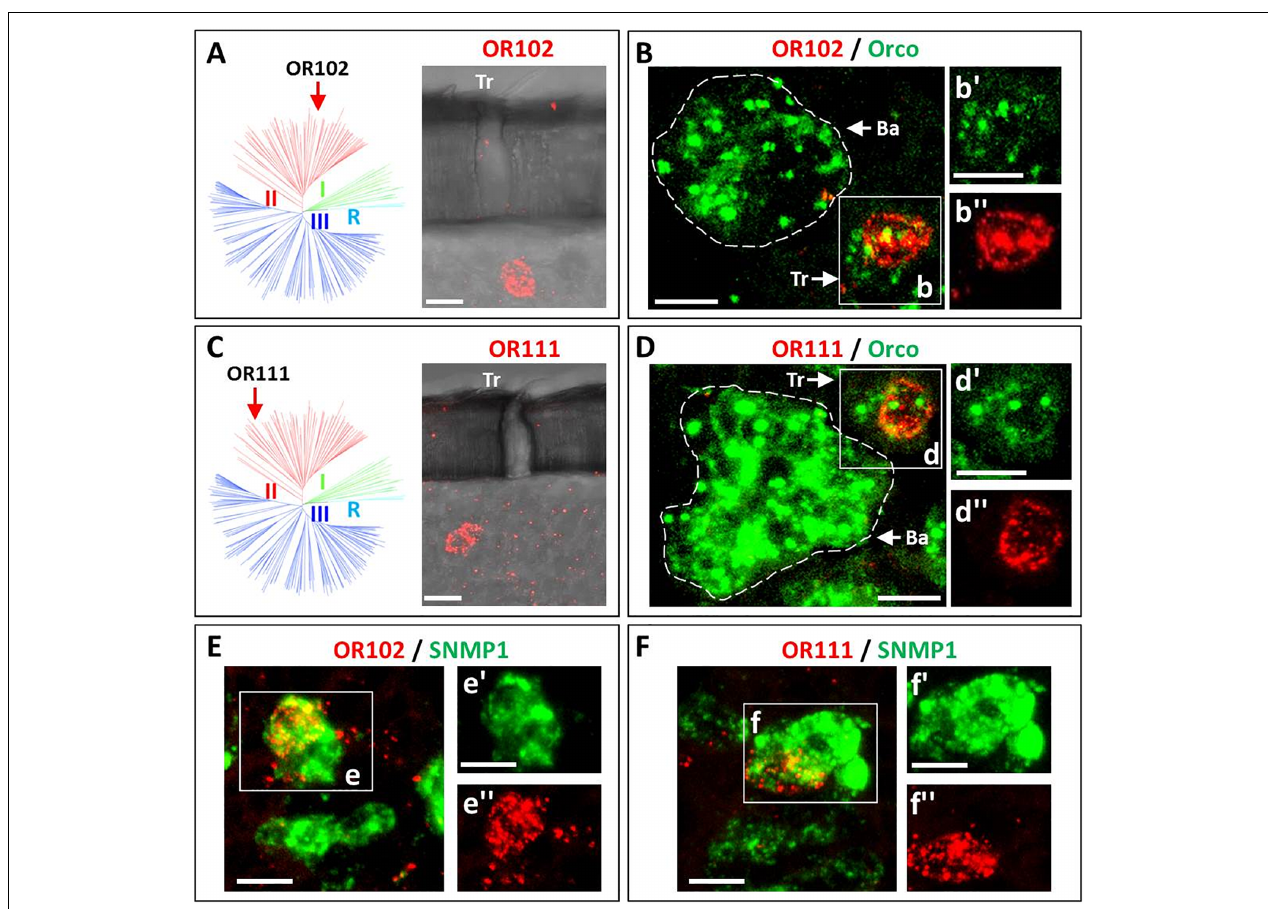
FIGURE 3 | Two ORs from group II are specifically expressed in sensilla trichodea. Cells expressing distinct OR types as well as Orco or SNMP1 were visualized by means of two-color FISH using specific antisense riboprobes labeled in either DIG (OR, red fluorescence) or Bio (Orco and SNMP1, green fluorescence). (A–D) The expression of OR102 and OR111 in cells housed in sensilla trichodea is visualized. As indicated in A (OR102) and in C (OR111) labeled cells are located under trichoid (Tr) sensillar hairs. In panel B,D co-localization of the two trichoid OR types with Orco are depicted. Discernable basiconic sensilla (Ba) and trichoid sensilla (Tr) cell clusters are indicated by white dash circles and white boxes (B,D) , respectively. The insets panel B’–D” depict the separate fluorescence channels of panels B,D . The white dash circle highlights the cell that concomitantly expresses the defined OR type and Orco. (E,F) The co-expression of OR102 and OR111 with SNMP1 is documented. In the insects panels E’–F” the separate fluorescence channels of the white boxed areas in panels E,F are depicted. The double labeled areas are indicated by white dash circles. Scale bars, 10 µ m.